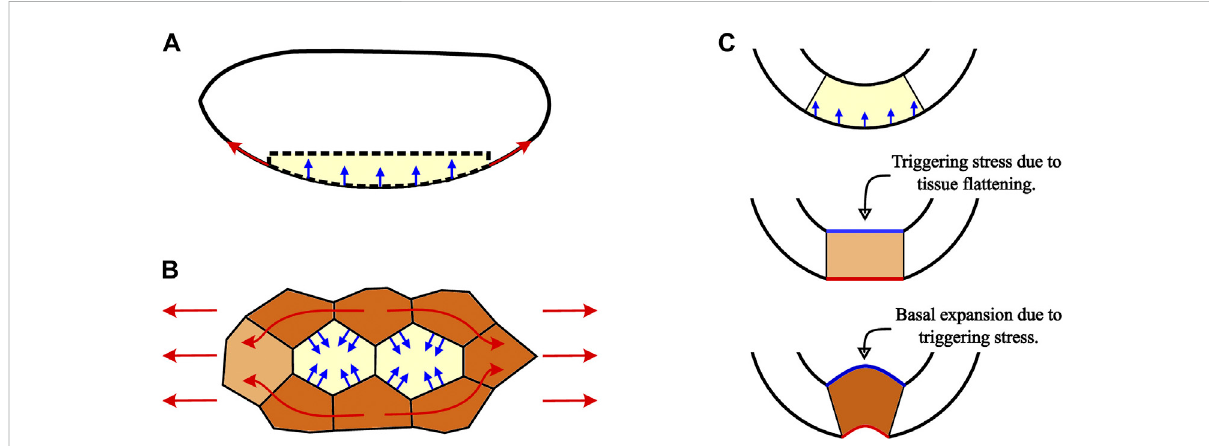
FIGURE 11 Schematic of how the percolation of tension along CCCs generates region-wide changes to help produce coherent invagination throughout the entire ventral fi eld. (A) Anteroposterior tension (red arrows) that builds up along the active region between the relatively immobile anterior and posteriorendcapsofthe Drosophila embryocausesaregion-widedorsoventralcompression(bluearrows)thatpushestheentireregioninwards. (B) Regions of unconstricted cells (yellow) that are surrounded by cells already in the constriction chains (brown) experience compressive forces (blue arrows) arising from the anteroposterior tension in the CCCs (red arrows). These transverse compressive forces, acting perpendicular to the tensile stress direction, cause cells between constriction chains to reduce their apical areas as the tension increases, despite these cells having completed few or no ratcheted pulses. Thus, CCCs carrying tension along the anteroposterior axis and the cells compressed by the chains synchronously reduce apical areas throughout the whole ventral furrow fi eld. (C) Cross-sectional embryo schematic showing how stresses associated with formation of CCCs can trigger the invagination phase of VFF. When the active region moves inward and fl attens as a result of a combination of local apical constrictions and the inward pressure generated by the high-tension network of CCCs, compressive stress develops along the basal surface (straight blue line). Mechanical stress feedback then promotes the basal expansion that is necessary for successful invagination of the